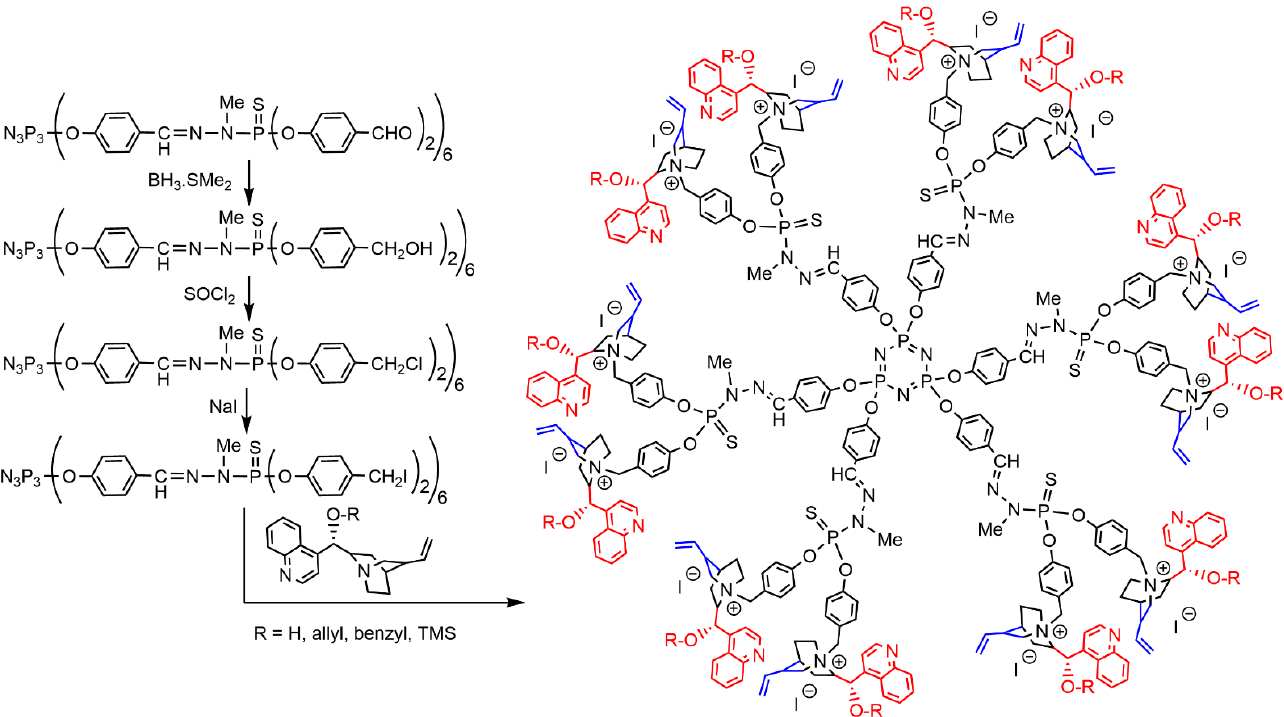
Figure 5. Catalytic reactions carried out with Pd complexes of the dendrimers shown in Scheme 5. ( A ) Suzuki coupling; ( B ) Sonogashira coupling; ( C , D ) Heck couplings.